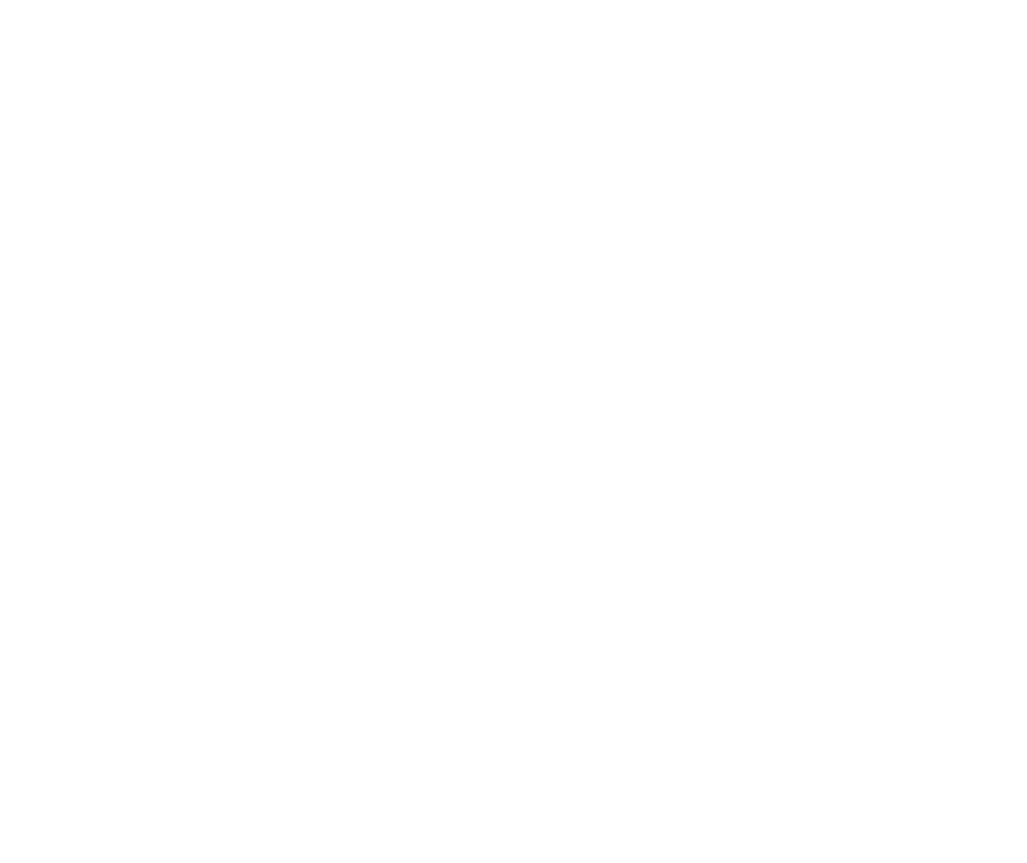
Perspective view of the title compound showing the atom-labelling scheme. Displacement ellipsoids are drawn at the 50% probability level. Symmetry code: (i) x , - y + 1/2,